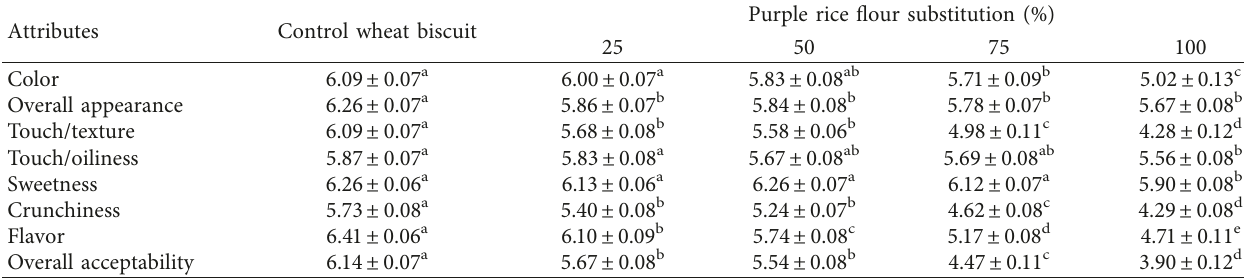
Table 6: Mean liking scores of sensory evaluation of the biscuits containing different levels of purple rice flours ∗